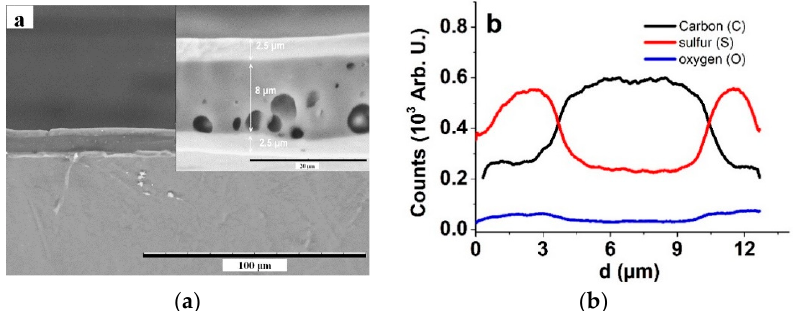
Figure 1. SEM images of a cross section of PP–IPN trilayer (scale bar 100 µm), including an inset for the thickness estimation of different layers. ( b ) EDX spectroscopy line scan of elemental composition of the cross section (inset of a ) showing carbon (C, black), sulfur (S, red), and oxygen (O, blue) relative content.